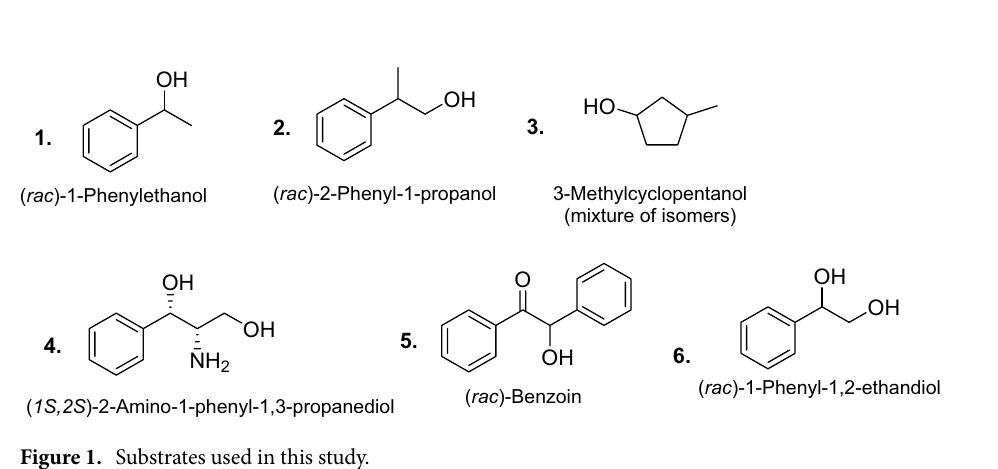
Figure 1. Substrates used in this